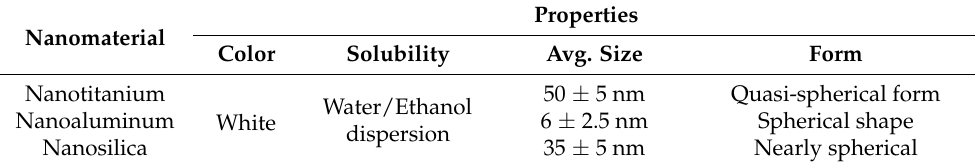
Table 1. Nanomaterials properties [24].